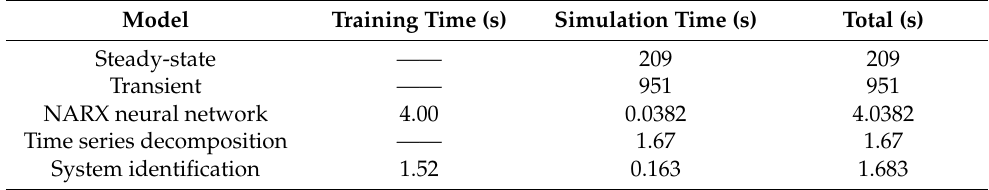
Table 6. Comparison of simulation time.